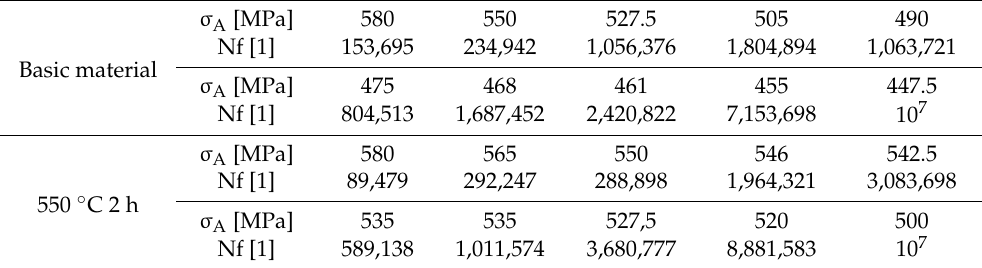
Figure 7. Sample in the device Gleeble 3500.